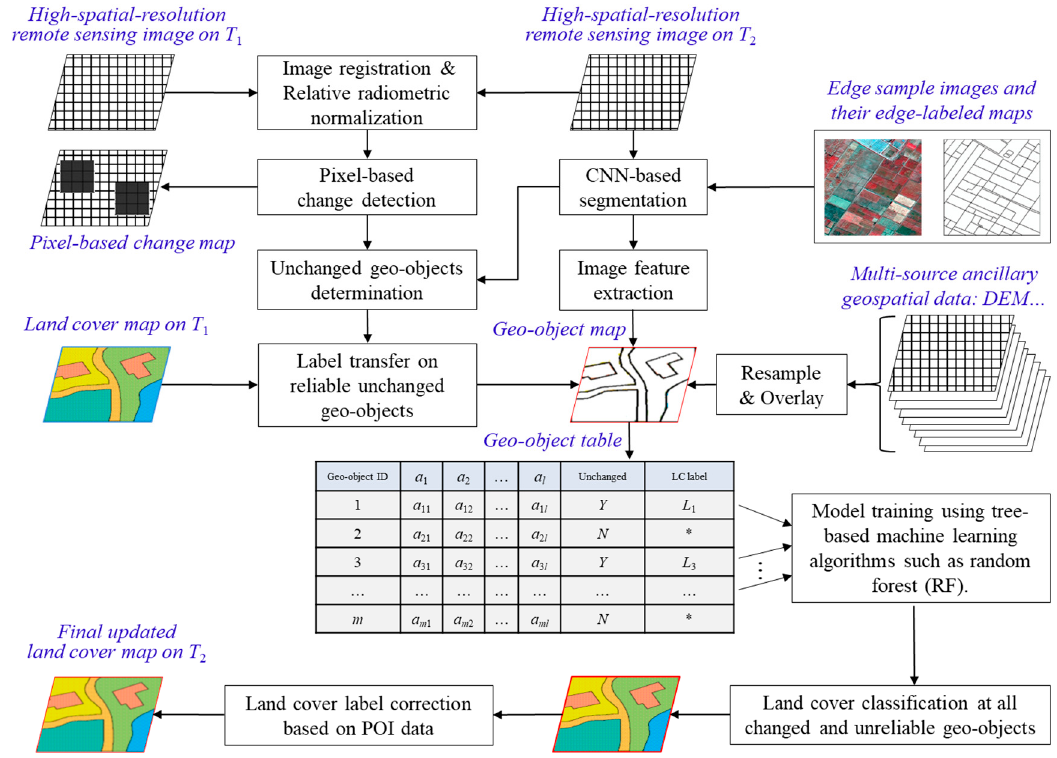
Figure 3. Diagram of the proposed geo-object-based automatic land cover update (Auto-LCU) method.